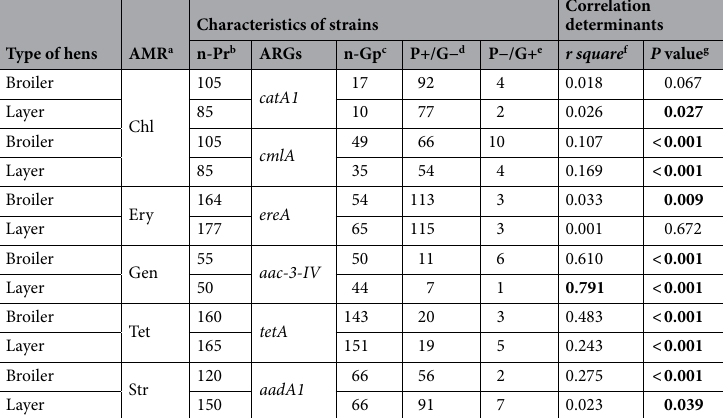
medically used antibiotics, such as ampicillin, erythromycin, and tetracycline. These findings were more or less similar to the findings of other researchers 42,43 . A similar study in Ethiopia showed that E. coli isolates from broiler chicken were resistant to tetracycline (90%), streptomycin (78%), ampicillin (60%) and highly sensitive to gentamicin (77%) 44 . In this study, among the seven tested non-beta-lactam antibiotic resistance genes, the prevalence of tetracy- cline ( tetA ), sulphonamides ( sul1 ), and streptomycin ( aadA1 ) resistance genes were the highest (72.58%, 44.67% and 33.50%, respectively), followed by erythromycin ( ereA ) (31.23%) and the two chloramphenicol resistant genes cmlA (22.05%) and catA1 (7.09%). Our findings indicate that chicken meat E. coli could be a reservoir of resistance genes, which may later become transferred to other common pathogens. In a similar study, the prevalence rates of tetA, aadA1 and sul1 ARGs in E. coli isolated from Vietnam were found to be 81%, 81%, and 27.1%, respectively 24 , while their respective rates in Portugal were 41.1%, 70.6% and 23.5% 45 . Additionally, Moawad et al. 37 reported that E. coli isolates from poultry meat were resistant to tetracy- cline (80.9%), streptomycin (61.9%) and trimethoprim/sulphamethoxazole (61.9%), which is higher than the prevalence rates reported in our present study. In Bangladesh, 37–100% of the poultry-derived E. coli strains were found resistant to chloramphenicol, tetracycline, streptomycin, erythromycin and penicillin, as reported by Rahman et al. and Islam et al. 46,47 . The lowest prevalence rate was observed with aac-3-IV (gentamicin resistance gene; 24.67%) which may be attributed to the very low absorption rate of gentamycin in poultry 48 . We showed that 75.06% of our E. coli isolates were resistant to at least three antibiotics. In a study conducted in Iran, a high prevalence rate (64.91%) of MDR strains among E. coli isolates from commercial chicken meat has been reported 49 . Studies have demonstrated even higher prevalence rates of MDR E. coli in broiler (94%) and layer (60%) chicken in India 50 and in Nepal (80.0%) 51 . Such high prevalence of MDR isolates may be due to misuse of antibiotics, which may ultimately replace the drug sensitive microorganisms in an antibiotic saturated environment 52 . In our study, a total of 53 (13.91%) beta-lactam antibiotic resistant E. coli isolates were identified from broiler ( n = 33; 16.75%) and layer ( n = 20; 10.87%) chicken meat. Among the 5 types of bla genes (TEM, CTX-M, CTX- M-1, CTX-M-2 and SHV) tested by multiplex PCR in the current study, only the bla SHV gene was detected in our E. coli isolates. In a study conducted in Netherlands, bla CTX-M-1 (58.1%) has been found to be the most common gene in chicken meat, followed by bla TEM-52 (14%) and bla SHV-12 (14%) 53 . In another study conducted in Egypt, TEM, CTX-M and SHV genes have been detected in 57.55%, 46.23% and 23.58% of the isolates, respectively 54 . Highly prevalent ESBL-producing E. coli strains in meat samples from broiler (87%) and layer (42%) chickens have been previously reported in India 50 , Nepal (36.9%) 51 and Vietnam (37%) 55 . In a previous study, the AmpC gene has been found to be mostly plasmid-associated whereas the chromosomal AmpC was found in a small percentage of E. coli 56 . In Vietnam and Italy, 84.2% 24 and 11.2% 57 , respectively, of the chicken meat isolates carried plasmid-associated AmpC genes, which is higher than the prevalence among the isolates of the current study. Over expression of ESBL and AmpC beta-lactamases in gram-negative bacteria may reduce therapeutic options for treatment of their infections by providing resistance to most beta-lactam antibiotics 58 .